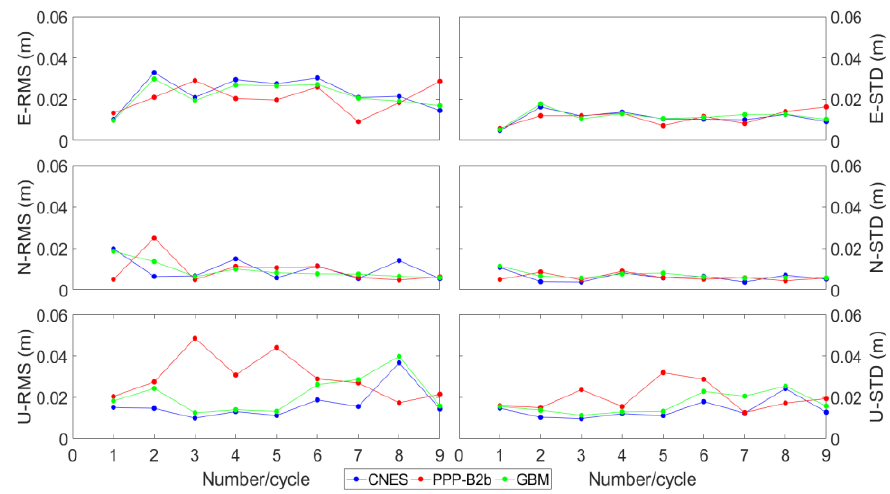
Figure 16. The STD and RMS values of positioning accuracy for WHU2 station.